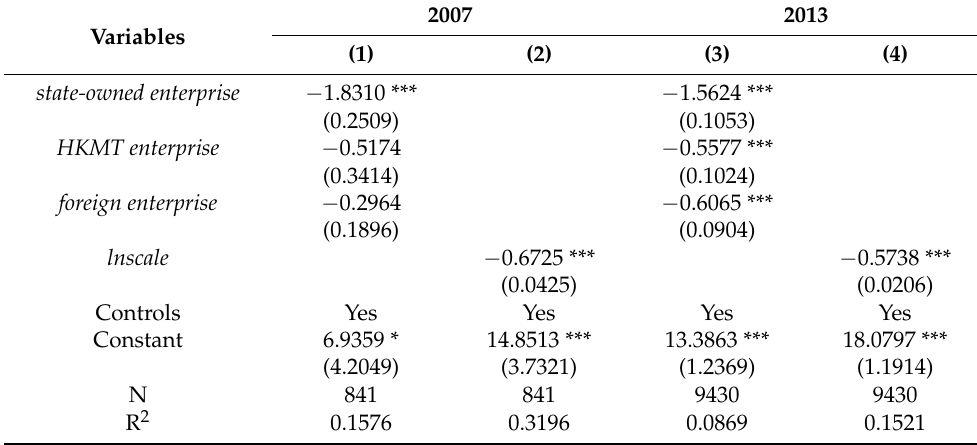
Table 10. Results of enterprises’ willingness to bid when industrial land is transferred through